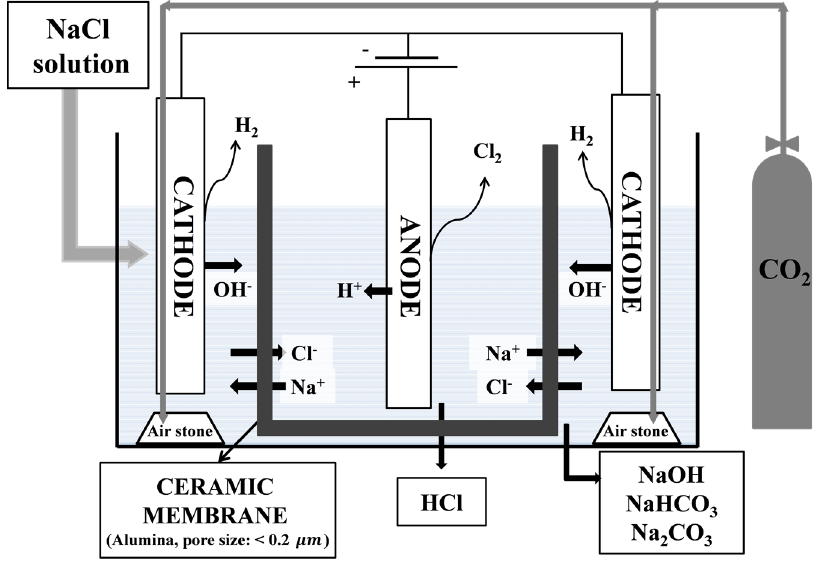
Figure 1. Schematic diagrams of the electrolysis device for the electrolysis of NaCl